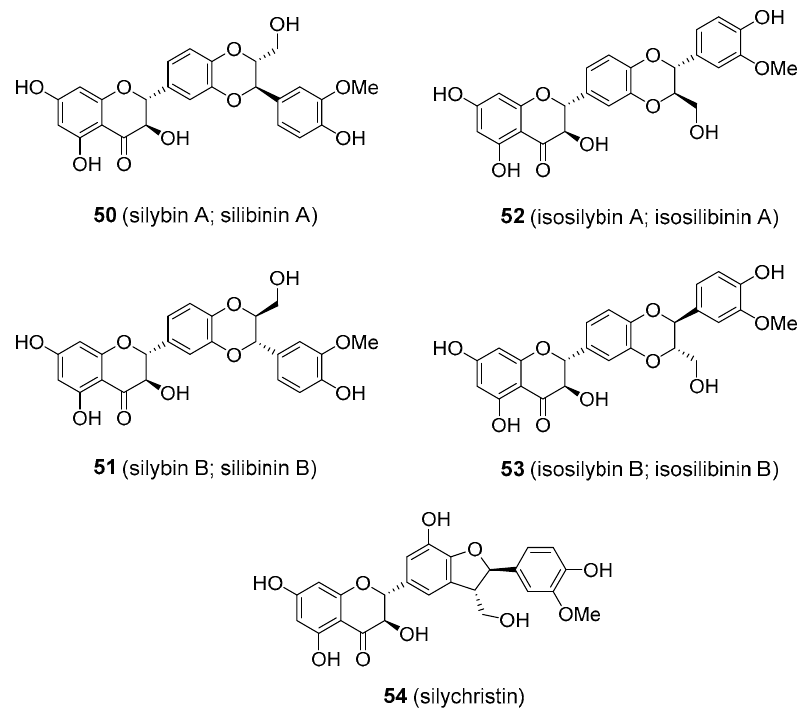
Figure 13. Flavonolignans from the milk thistle ( Silybum marianum ; Asteraceae) collectively termed as silymarins.